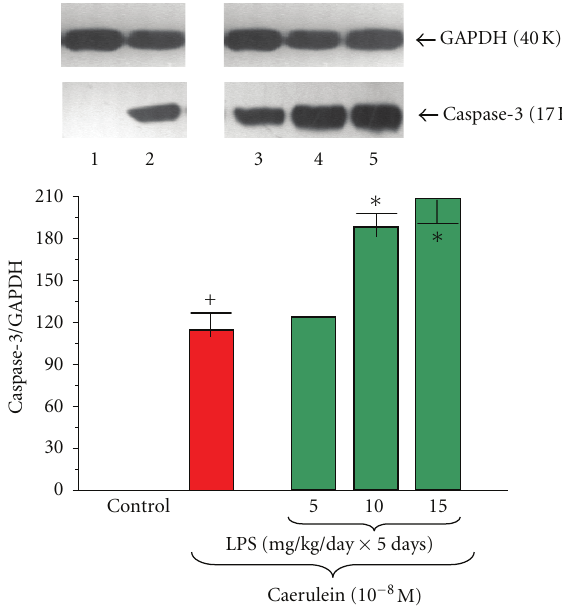
Figure 13: Western blot analysis of apoptosis executioner caspase- 3 protein level in the adult rat pancreatic acinar cells under basal conditions (lane 1), stimulated in vitro by caerulein at the dose of 10 − 8 M (lane 2), treated in the infant animals by lipopolysaccharide ( Escherichia coli ) at the doses of 5mg/kg/day × 5 days + caerulein 10 − 8 M (lane 3), 10 mg/kg/day × 5 days + caerulein 10 − 8 M (lane 4), and 15 mg/kg/day × 5 days + caerulein 10 − 8 M (lane 5) after 5 hours of incubation. Cross indicates significant ( P < 0 . 05) change, as compared to the control group. Asterisk indicates significant ( P < 0 . 05) change, as compared to the value obtained from the rats treated by increasing doses of LPS (10 or 15mg/kg/day × 5 days) in combination with caerulein (10 − 8 M), as compared to the caerulein (10 − 8 M) alone stimulation. The blots were stripped and probed with GAPDH to document equal protein loading. All presented results were obtained in 4 consecutive experiments and are representative of the observed